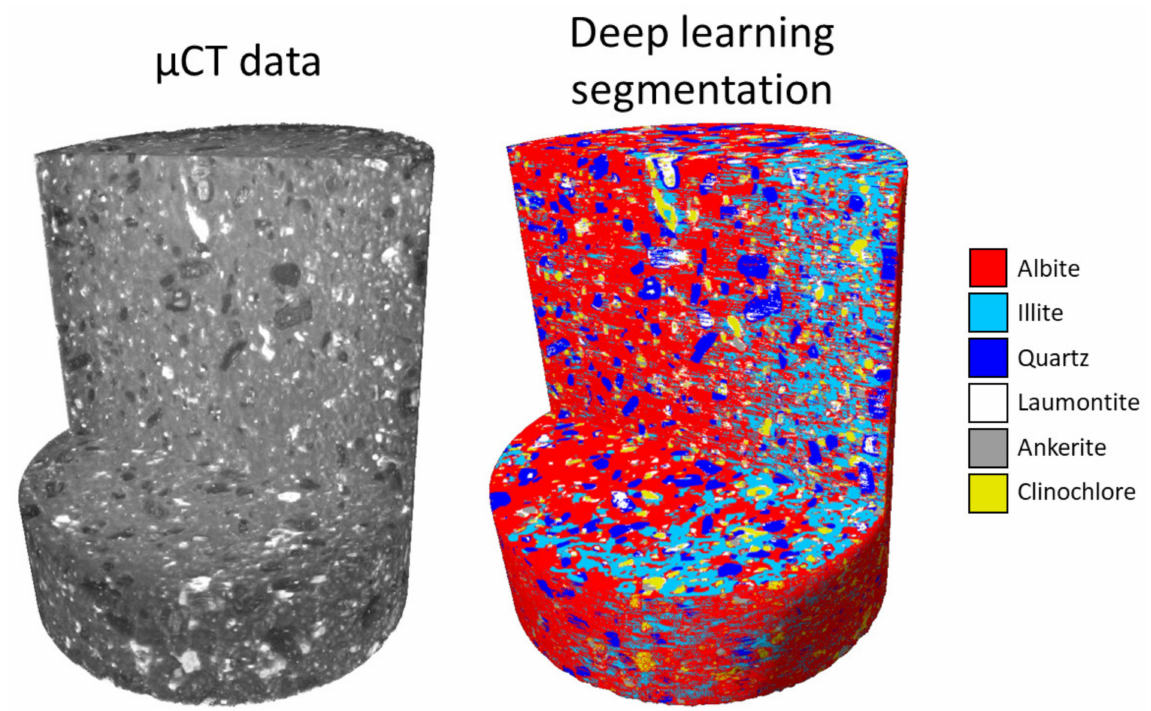
Figure 10. 3D tomography cutaway of the cylindrical basaltic andesite core plug ( left ) and the 3D segmentation performed by the deep learning model ( right